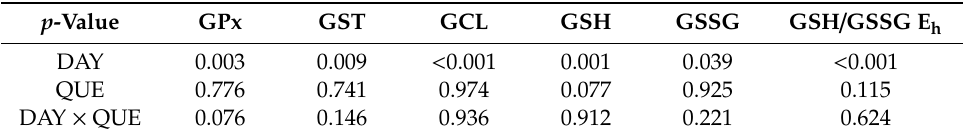
Table 4. Significance levels for treatment e ff ects on the glutathione redox system in blood of piglets at d5 and d14post-weaning (DAY), fed a diet containing 0, 100, 300, or 900 mg quercetin / kg diet